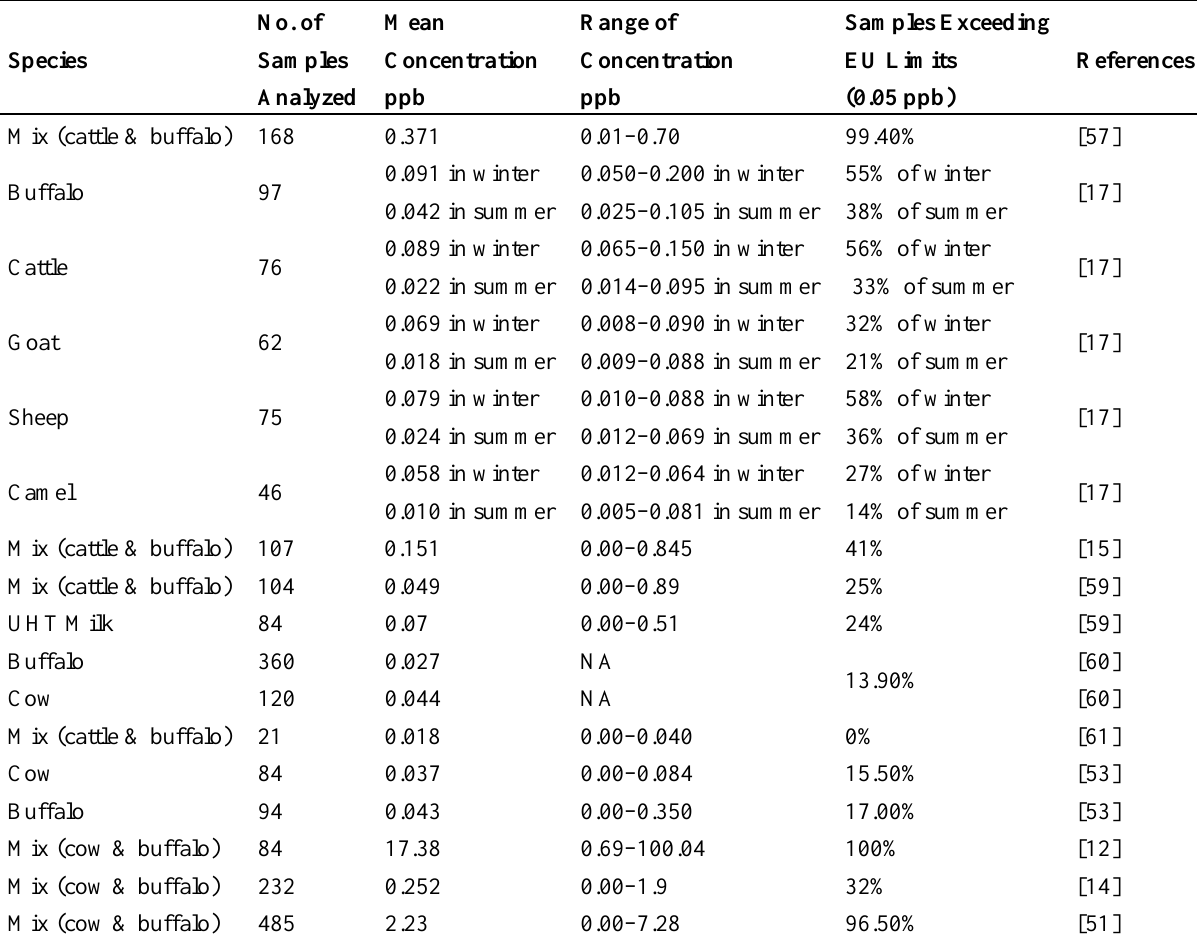
Table 2. Summary of some recent studies for aflatoxin M1 in milk in